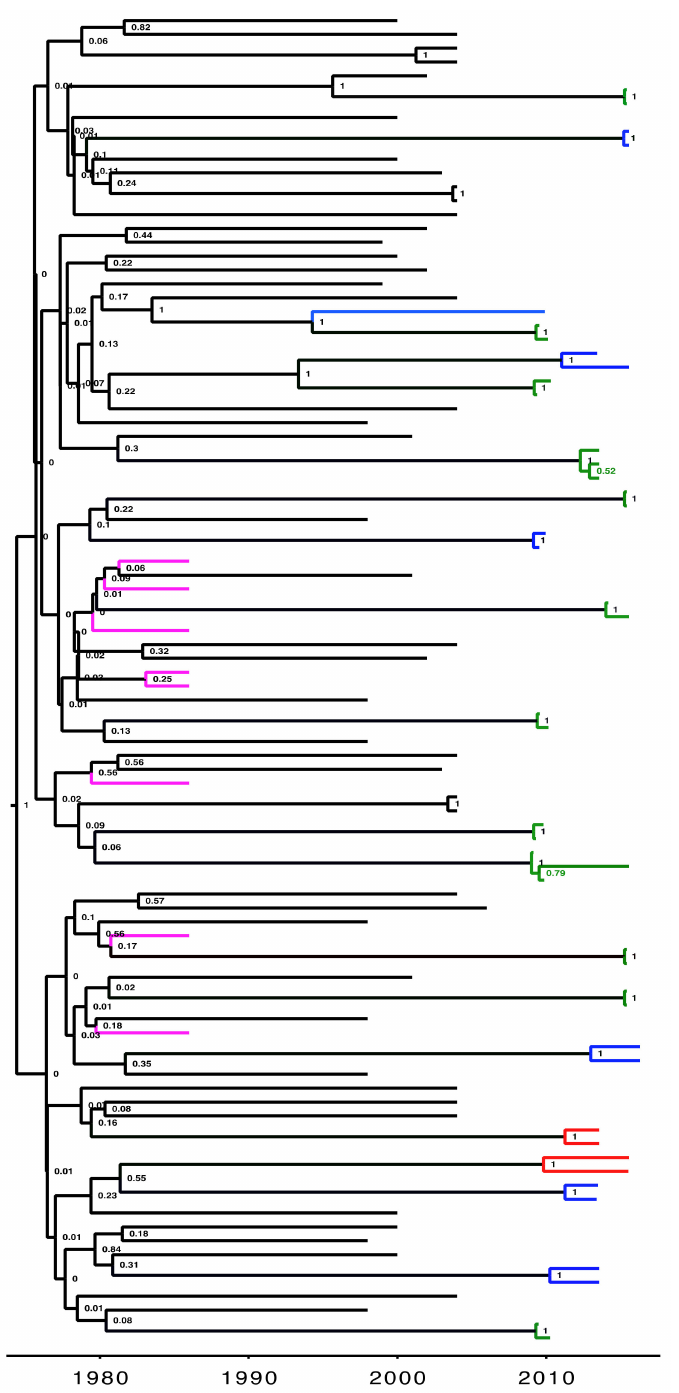
Figure 1. An example of a Maximum Clade Credibility (MCC) time-resolved phylogeny for HIV-1 sequences linked at a maximum genetic distance of 4.5%. Tips (without labels) on the tree represent sampled sequences that are linked (nodes supported by a high posterior probability of 1) with the branches colored according to the population (green, fisherfolk communities; red, female sex workers; blue, general population; purple, historical Ugandan samples collected during the early years (1980s) of the epidemic). The black colored branches are reference sequences that were downloaded from the Los Alamos HIV sequence database. Time scale at the bottom is in calendar